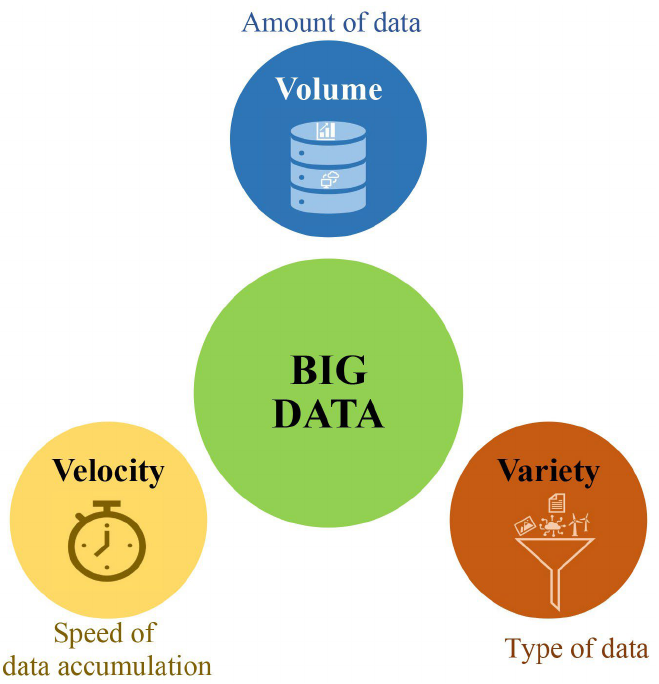
Figure 1. A schematic representation of the three Vs of bigdata. This figure was created using Excel, Microsoft O ffice 2021.